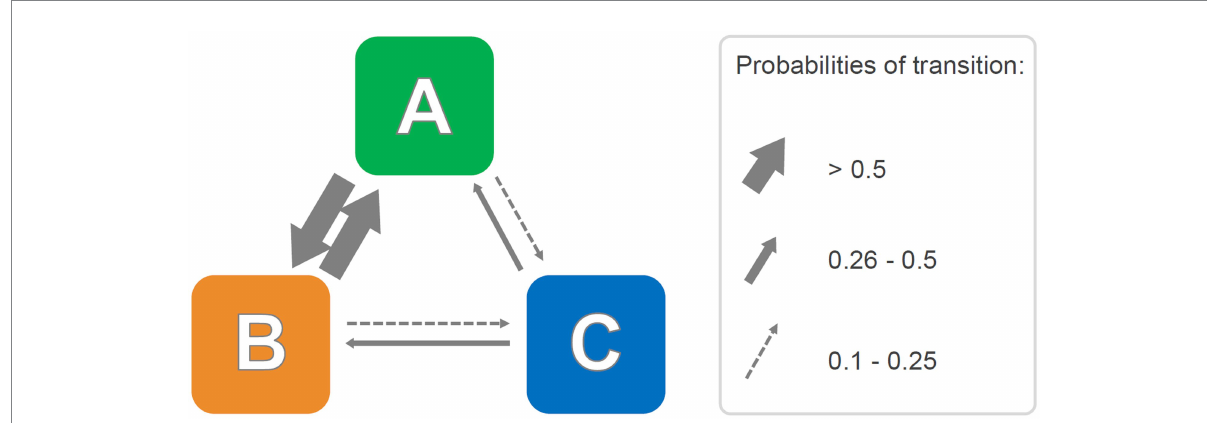
FIGURE 4 Hypothetical probabilistic pathway diagram representing transition probabilities among behavioral units. Right side, the selected probability ranges used to draw probability arrows of matching thickness. See text for